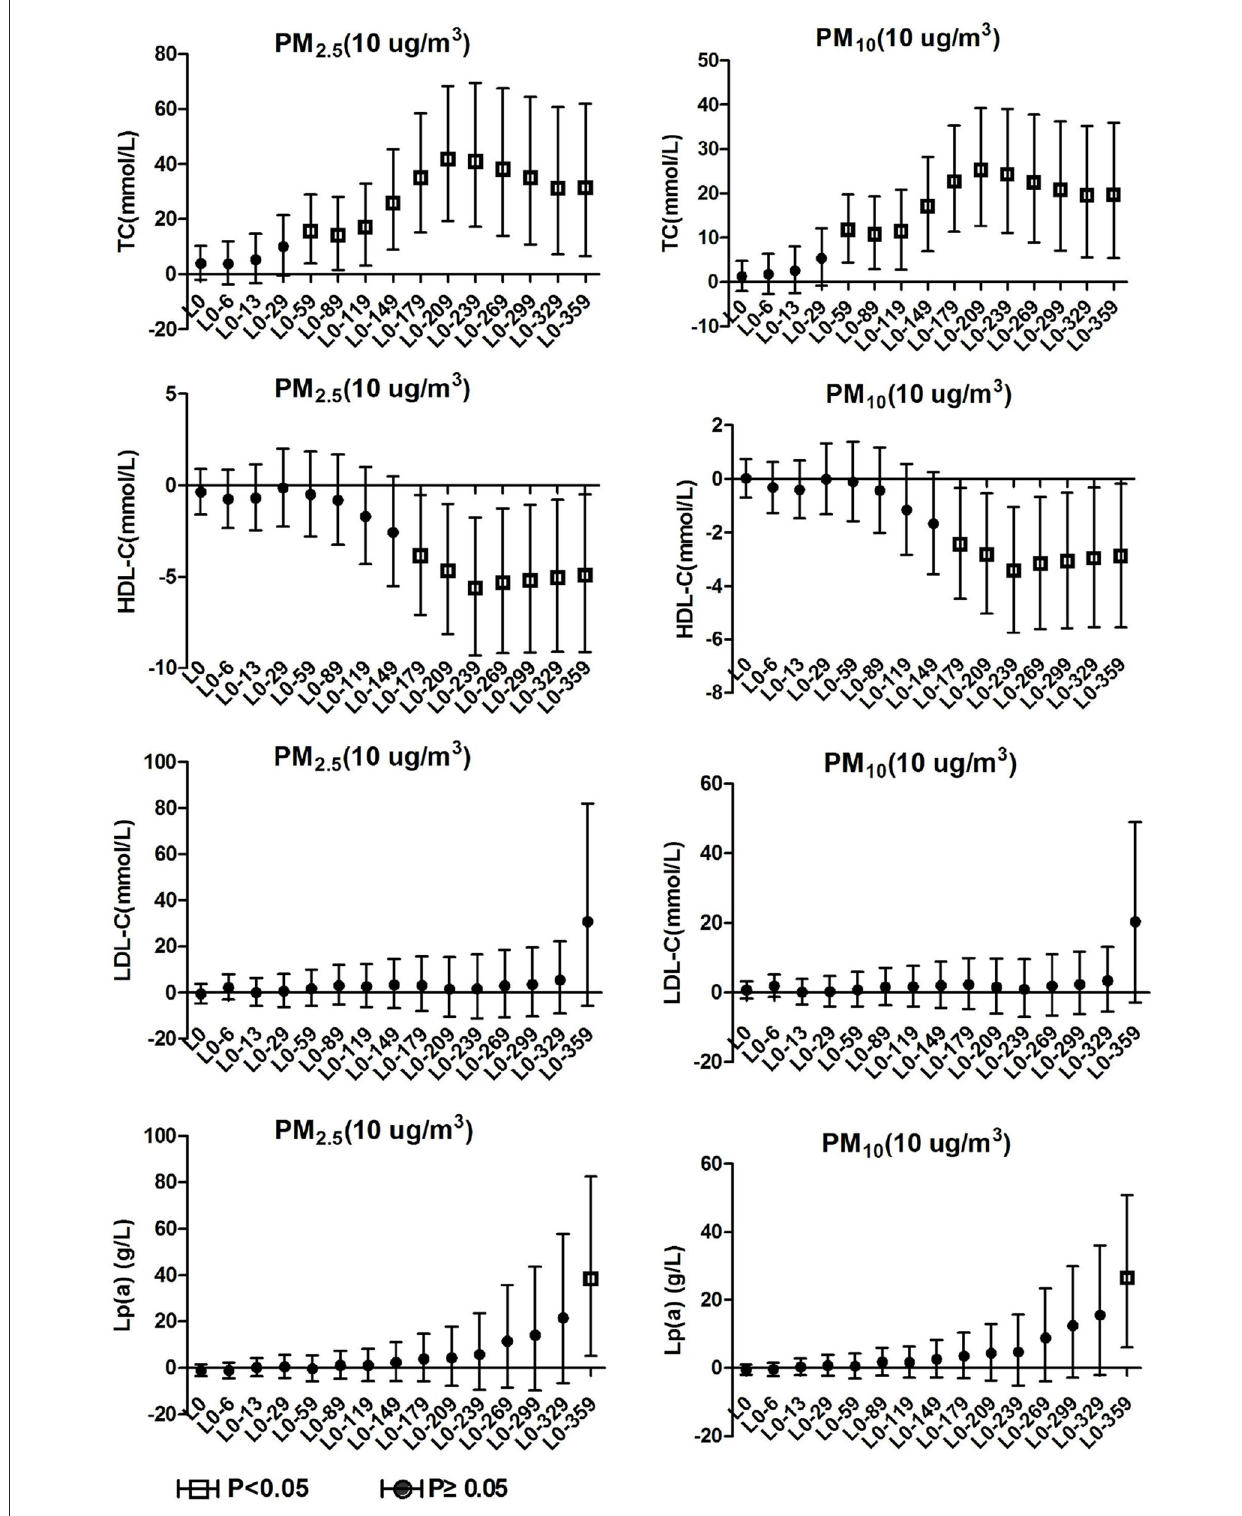
FIGURE3 Effect of PM 2.5 and PM 10 on blood lipid in hypertension inpatients with arteriosclerosis.